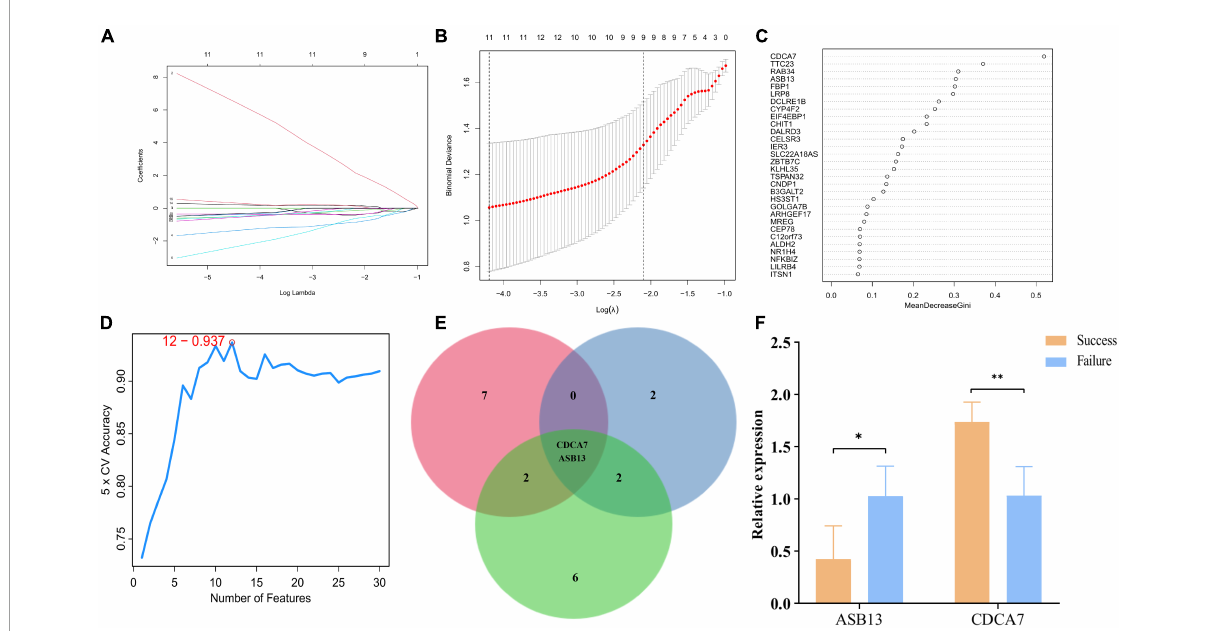
FIGURE3 Screening process of programmed cell death (PCD)-related prognostic genes. (A) Least absolute shrinkage and selection operator (LASSO) algorithm to screen PCD-related prognostic genes. (B) 10-fold cross-validation for the coefficients of 77 PCD-related differentially expressed genes in the LASSO model. (C) Plot of top 30 biomarker selected by random forest. (D) Further screening of top 30 biomarker by support vector machine (SVM)-RFE algorithm. (E) Venn diagrams of hub PCD-related prognostic genes from the three algorithms. (F) Quantitative polymerase chain reaction (qPCR) validation of the hub PCD-related prognostic genes; ∗ p < 0.05 vs. the failure treatment group; ∗∗ p < 0.01 vs. the failure treatment